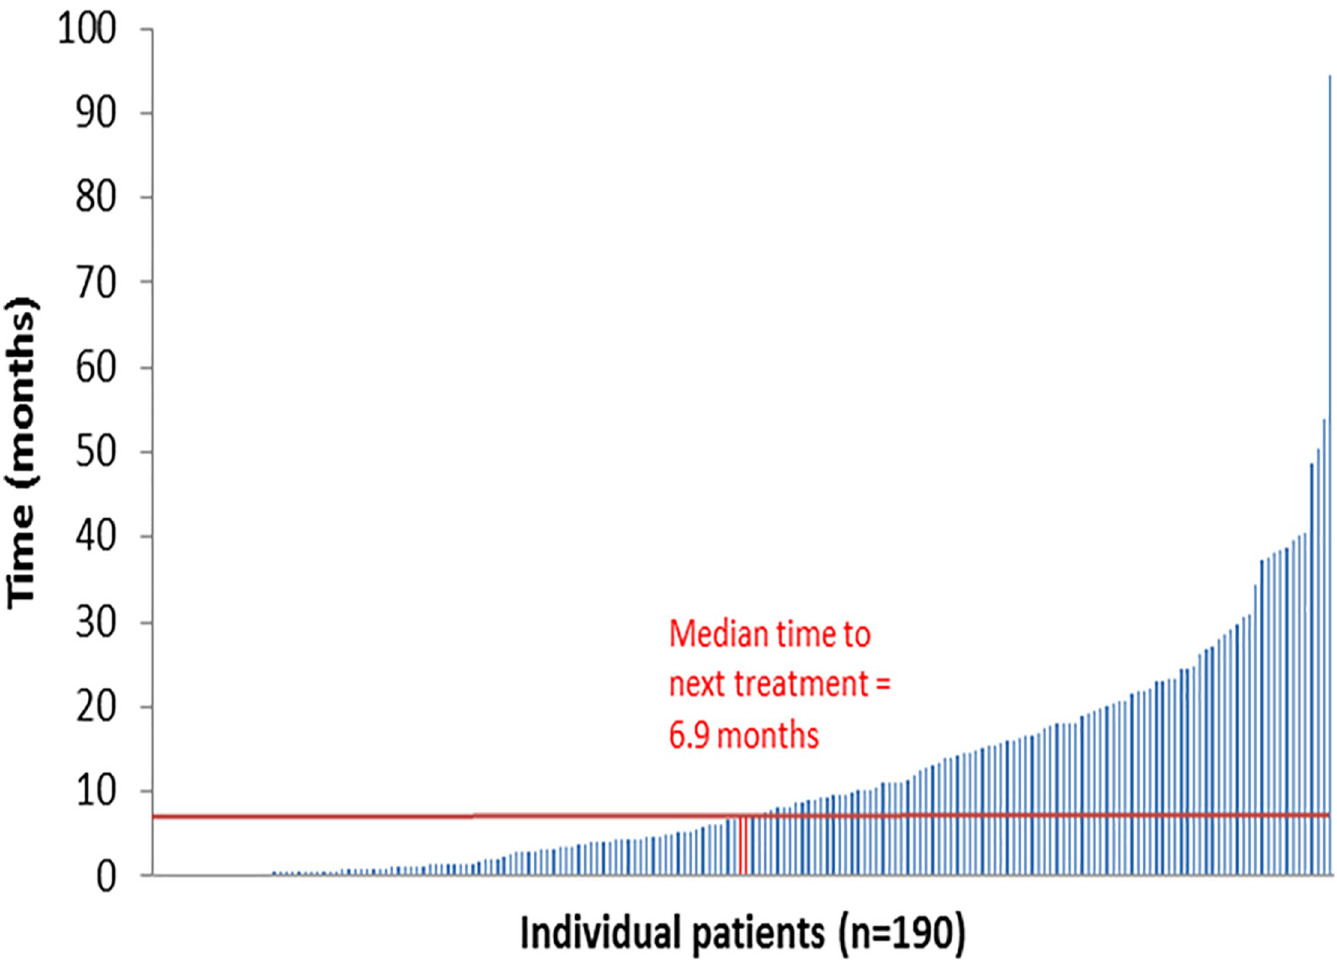
Fig 1. Waterfall plot of treatment-free interval following first-line therapy. Table 5. TFI in individual subgroups according to age were also longest after first line therapy, and decreased with increasing lines of therapy: � 75 years (median decreased from 7.5 months to 1.8 then to 0.5 months), > 75 years (median decreased from 6.1 months to 2.1 then to 1.2 months). Table 6. line therapy and decreased with increasing lines of therapy: In the mildly co-morbid group (CCI = 0–2), median TFI decreased from 4.8 months to 1.9 then to 0.4 months. In the moder-